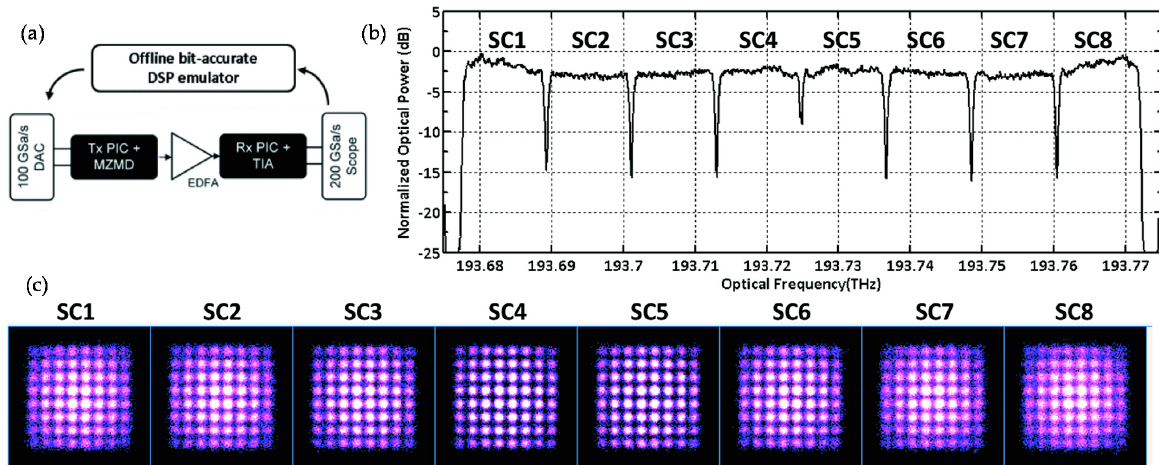
Figure 15. ( a ) Experimental setup for 800-Gbit/s transmission measurements; ( b ) optical spectra showing a single ~95-GHz wide channel with eight digital subcarriers (from SC1 to SC8); ( c ) all received eight subcarrier probabilistic shaping 64-QAM constellations; DAC: digital to analog converter; Table 1. the first subcarrier; DSP: digital signal processing; MZMD: Mach Zehnder modulator driver; PIC: photonic integrated circuit; TIA: trans-impedance amplifier; (From [27] © 2021